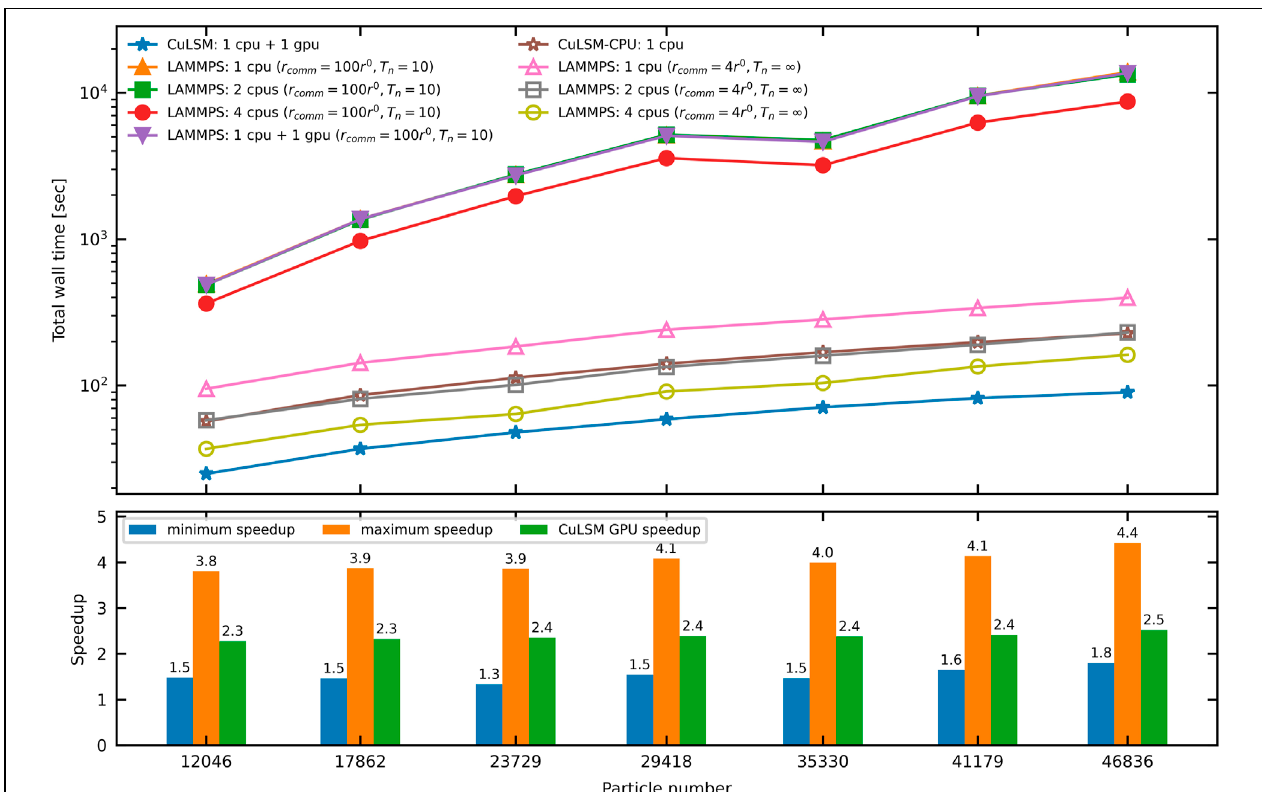
FIGURE 7 | Comparison of the total computing wall time by CuLSM and LAMMPS. Note that LAMMPS: 1 CPU + 1 GPU does not support parallelism on the spring list. The bottom panel compares the maximum and minimum speedup of CuLSM against LAMMPS of r comm = 4 r 0 and T n = ∞ . The maximum speedup compares CuLSM: 1 CPU + 1 GPU with LAMMPS: 1 CPU, and the minimum speedup compares CuLSM: 1 CPU + 1 GPU with LAMMPS: 4 CPUs. The GPU speedup of CuLSM (CuLSM: 1 CPU + 1 GPU versus CuLSM-CPU: 1 CPU) is presented.